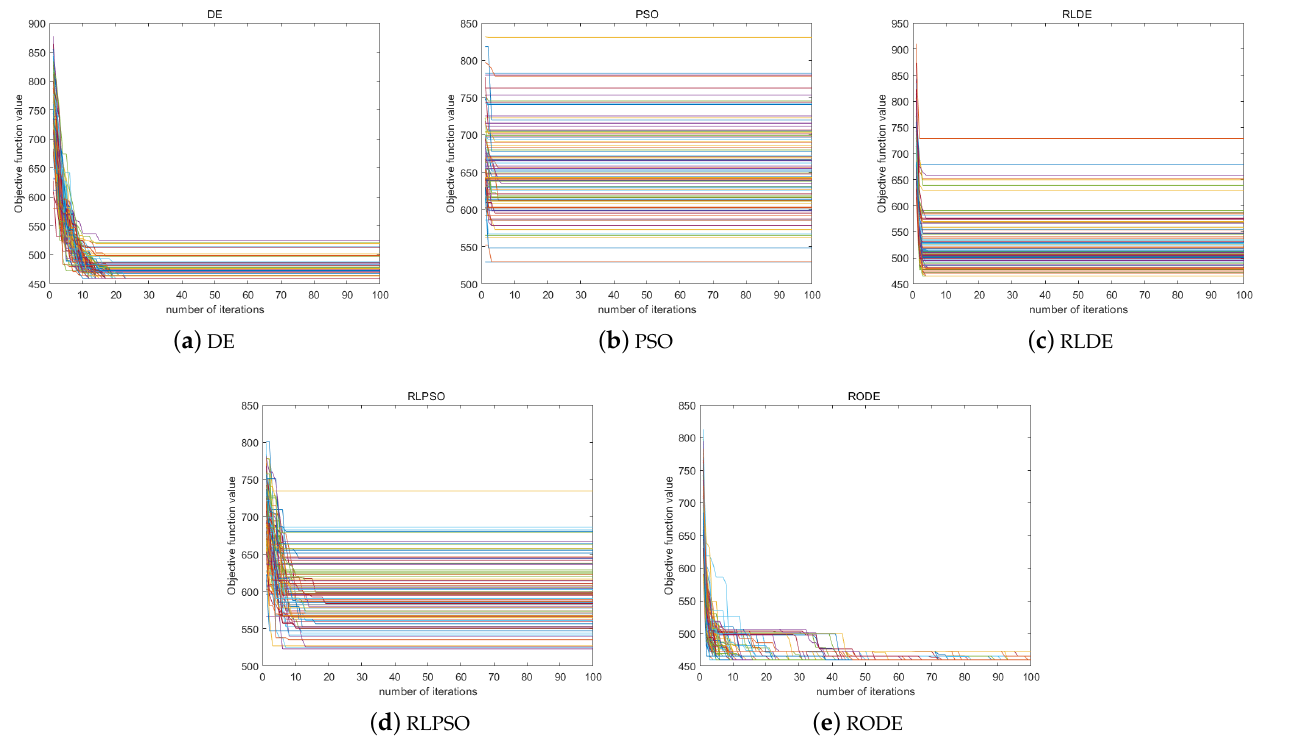
Figure 11. Algorithm convergence test when the initial population size is 10. ( a ) DE algorithm runs 100 times. ( b ) PSO algorithm runs 100 times. ( c ) RLDE algorithm runs 100 times. ( d ) RLPSO algorithm runs 100 times. ( e ) RODE algorithm runs 100 times. Table 6. The number of times each algorithm falls into the local optimal solution.